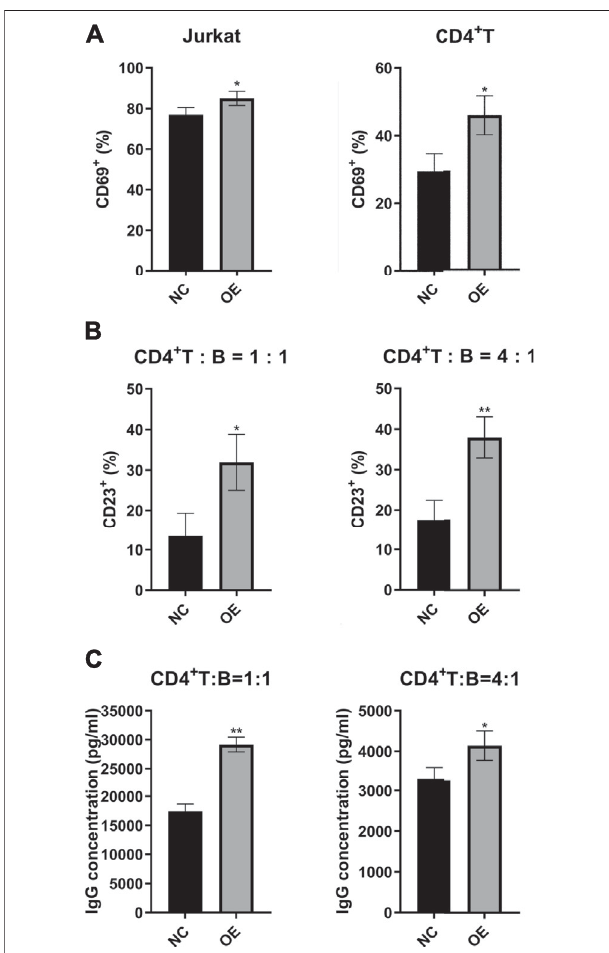
FIGURE3| LincRNA00892promoted theactivationofCD4 + T cellsand subsequent activation of B cells. (A) The CD69 levels expressed on the surface of both Jurkat and primary CD4 + T cells in negative control and lincRNA00892 overexpression groups were measured by fl ow cytometry. (B) TheCD23levelsexpressedonthesurfaceofBcellscocultured with primary CD4 + T cells transfected with control vector or vector containing lincRNA00892 fragment were con fi rmed by fl ow cytometry. (C) The primary CD4 + T cells that transfected with control vector or vector that containing lincRNA00892fragmentwerecoculturedwithBcellsataratioof1:1or4:1for 3 days.The levels ofIgG secreted by Bcells were determined byELISA. NC (cid:1) negative control, OE (cid:1) overexpression. ** p < 0.01, * p < 0.05. The results are expressed as mean ± standard deviation. Student ’ s t-test was used for comparison of two